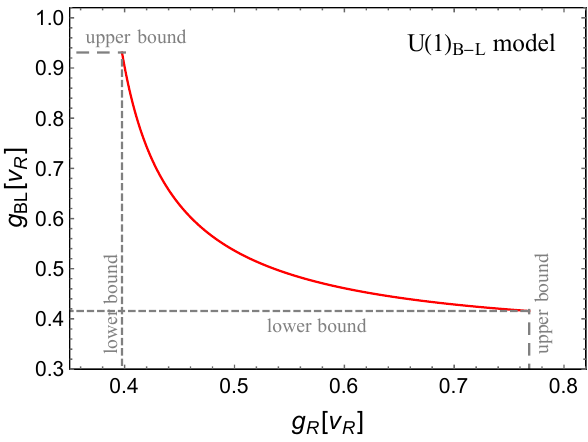
Figure 1 . Correlation of g R;BL ( v R ) and g R;BL ( M GUT ) in the U(1) B (cid:0) L model as functions of r g (cid:17) g R =g L at the v R scale (shown by the color coding). The horizontal shaded region is excluded p by the perturbativity limit g R;BL < 4 (cid:25) . The vertical dotted and dashed lines respectively denote the lower and upper limits on the gauge couplings. Here we have chosen v R = 5 TeV and M GUT = 10 16 GeV.